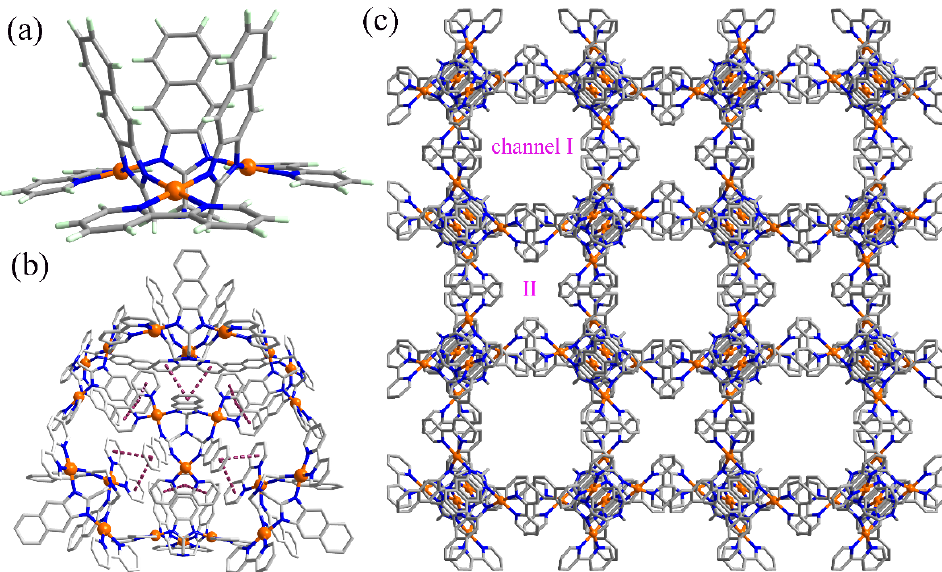
Figure 1. ( a ) The cup-shaped trinuclear [Pd 3 (bipy) 3 L] 3+ in a macrocycle. Atom color codes: Pd, orange; N, blue; C, gray; H, bright white. ( b ) View of each macrocycle associating with its six neighbors through π ··· π interactions. ( c ) The porous cubic supramolecular assembly showing two types of channels.